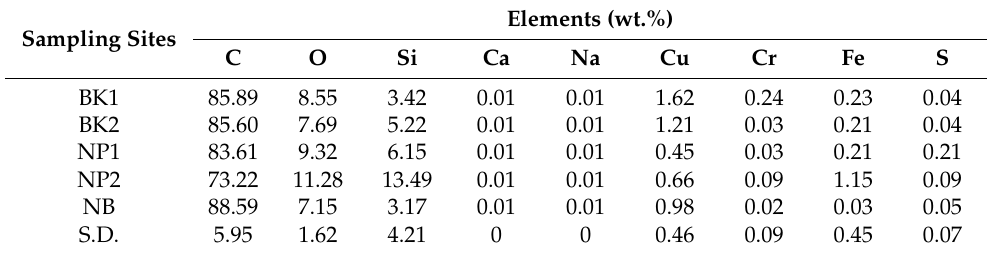
Table 2. Quantitative elemental analysis of PM10 samples in sampling sites by TEM-EDS. Sampling